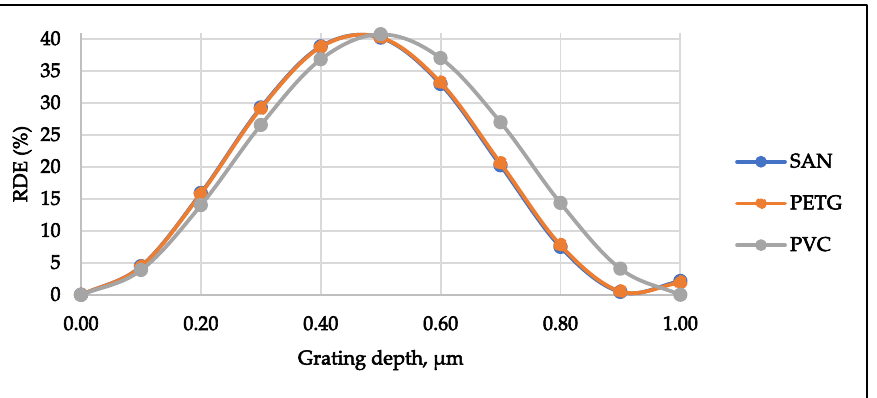
Figure 10. Dependence of the theoretical diffraction efficiency of plastics on the grating depth.